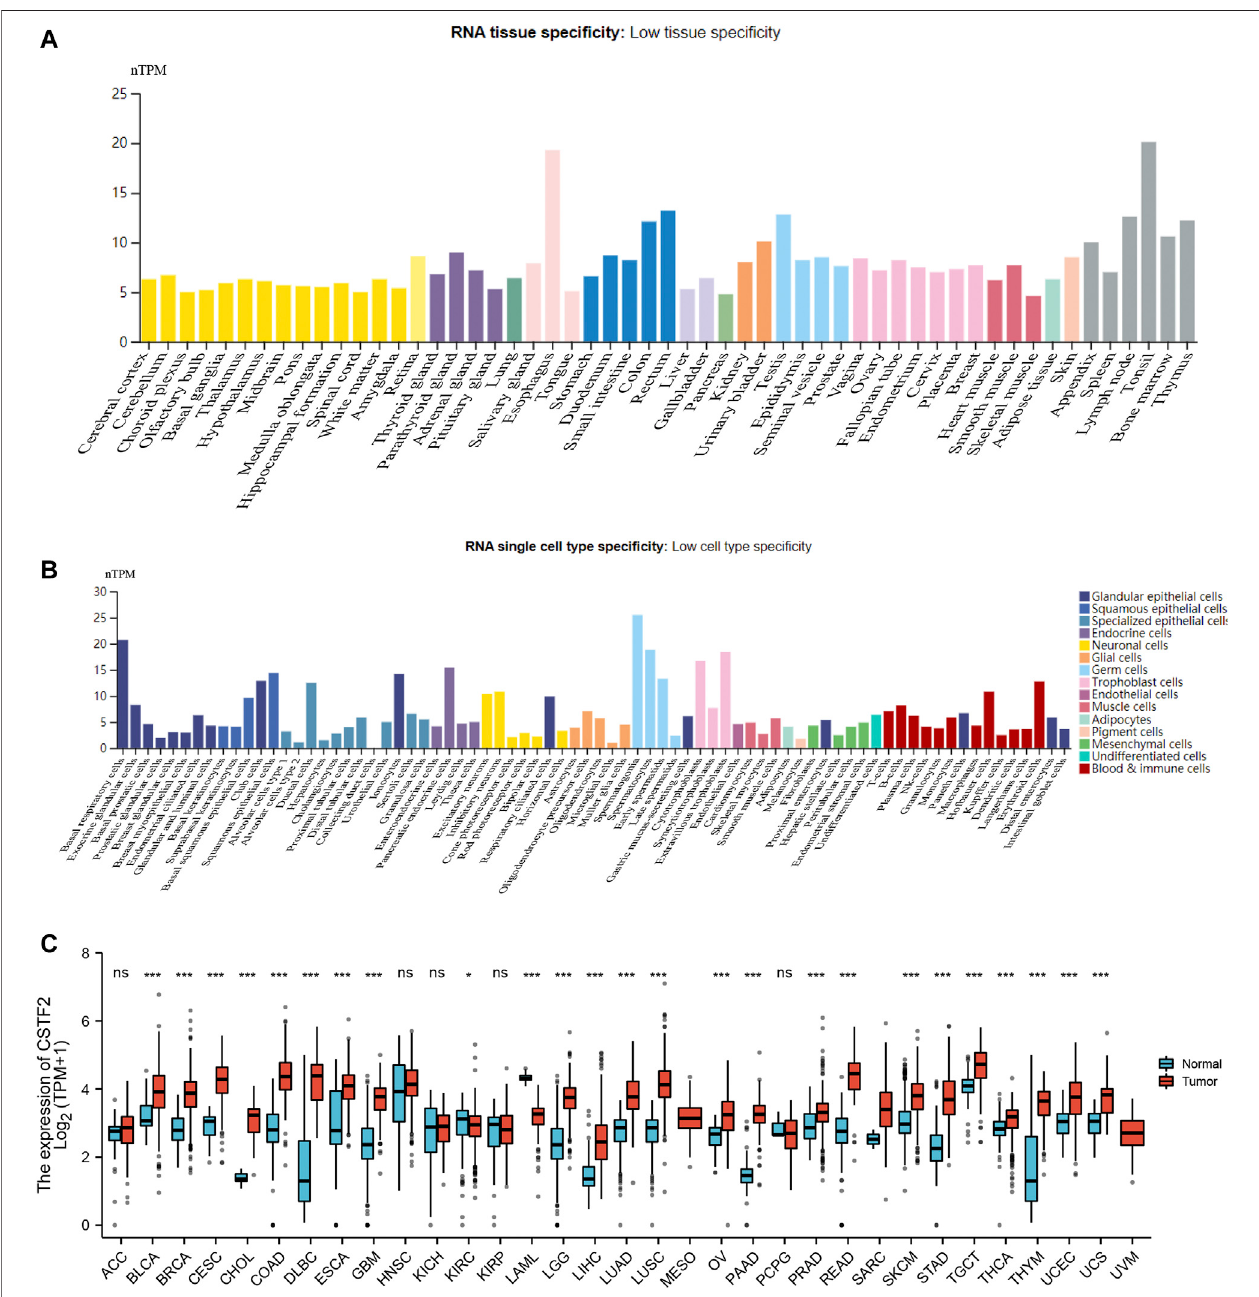
FIGURE 1 | Expression difference of CSTF2 in pan-carcinoma. (A) CSTF2 mRNA expression in 31 tissues. (B) Expression of CSTF2 in 21 normal cell lines. (C) Differences in expression of CSTF2 in various tumor cell lines and their corresponding normal tissues. nTPM indicates the normalized expression level of TPM data.